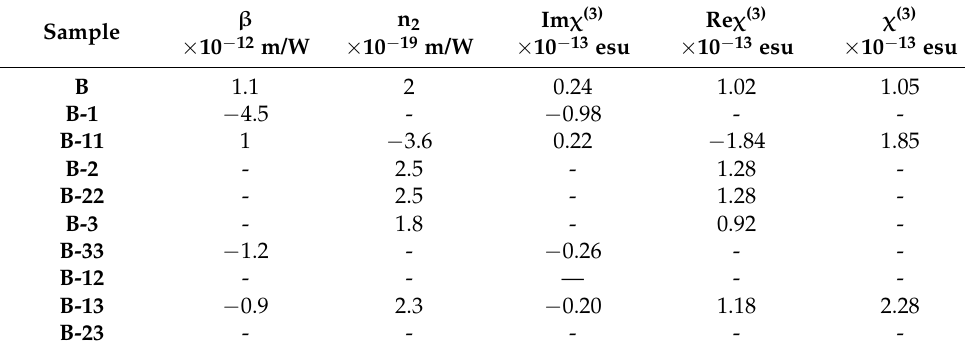
Table 2. NLO properties of the